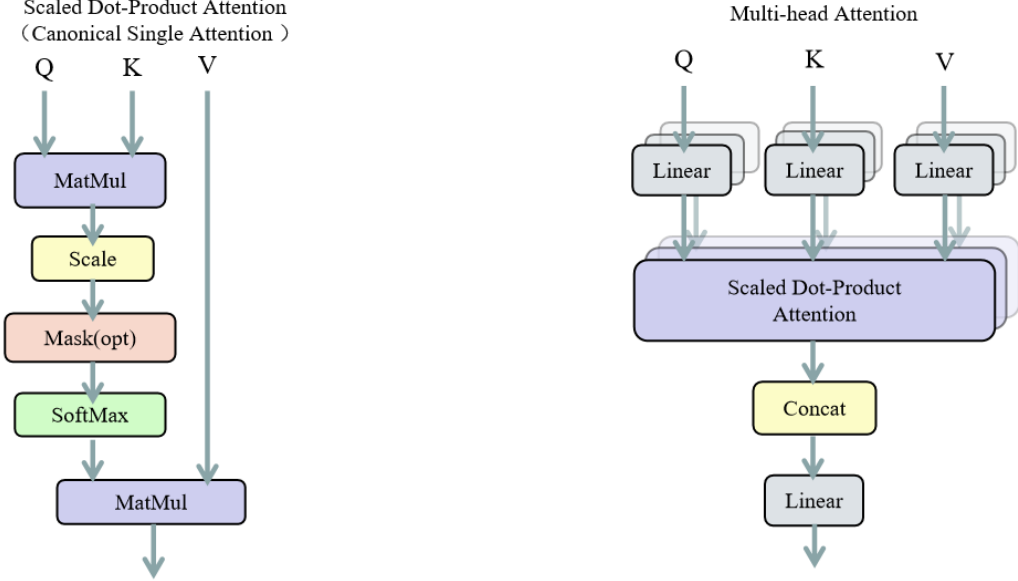
Figure 4. Canonical single self-attention function and Multi-head